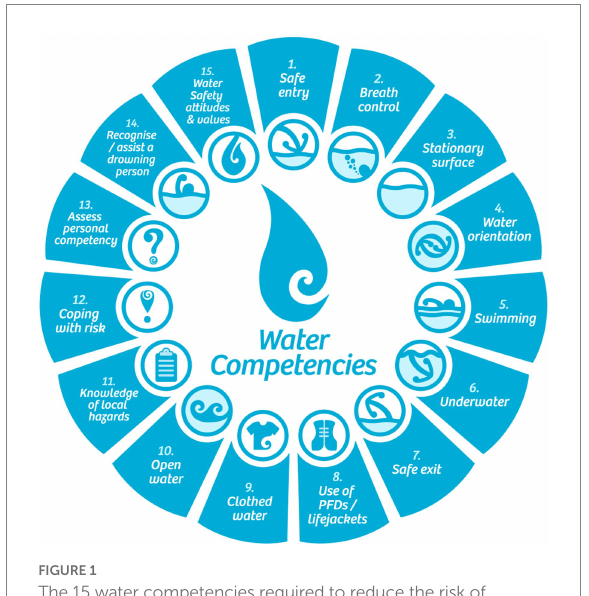
FIGURE 1 The 15 water competencies required to reduce the risk of drowning. Reproduced with permission of Drowning Prevention Auckland (https://www.dpanz.org.nz/courses/water-safety-for-